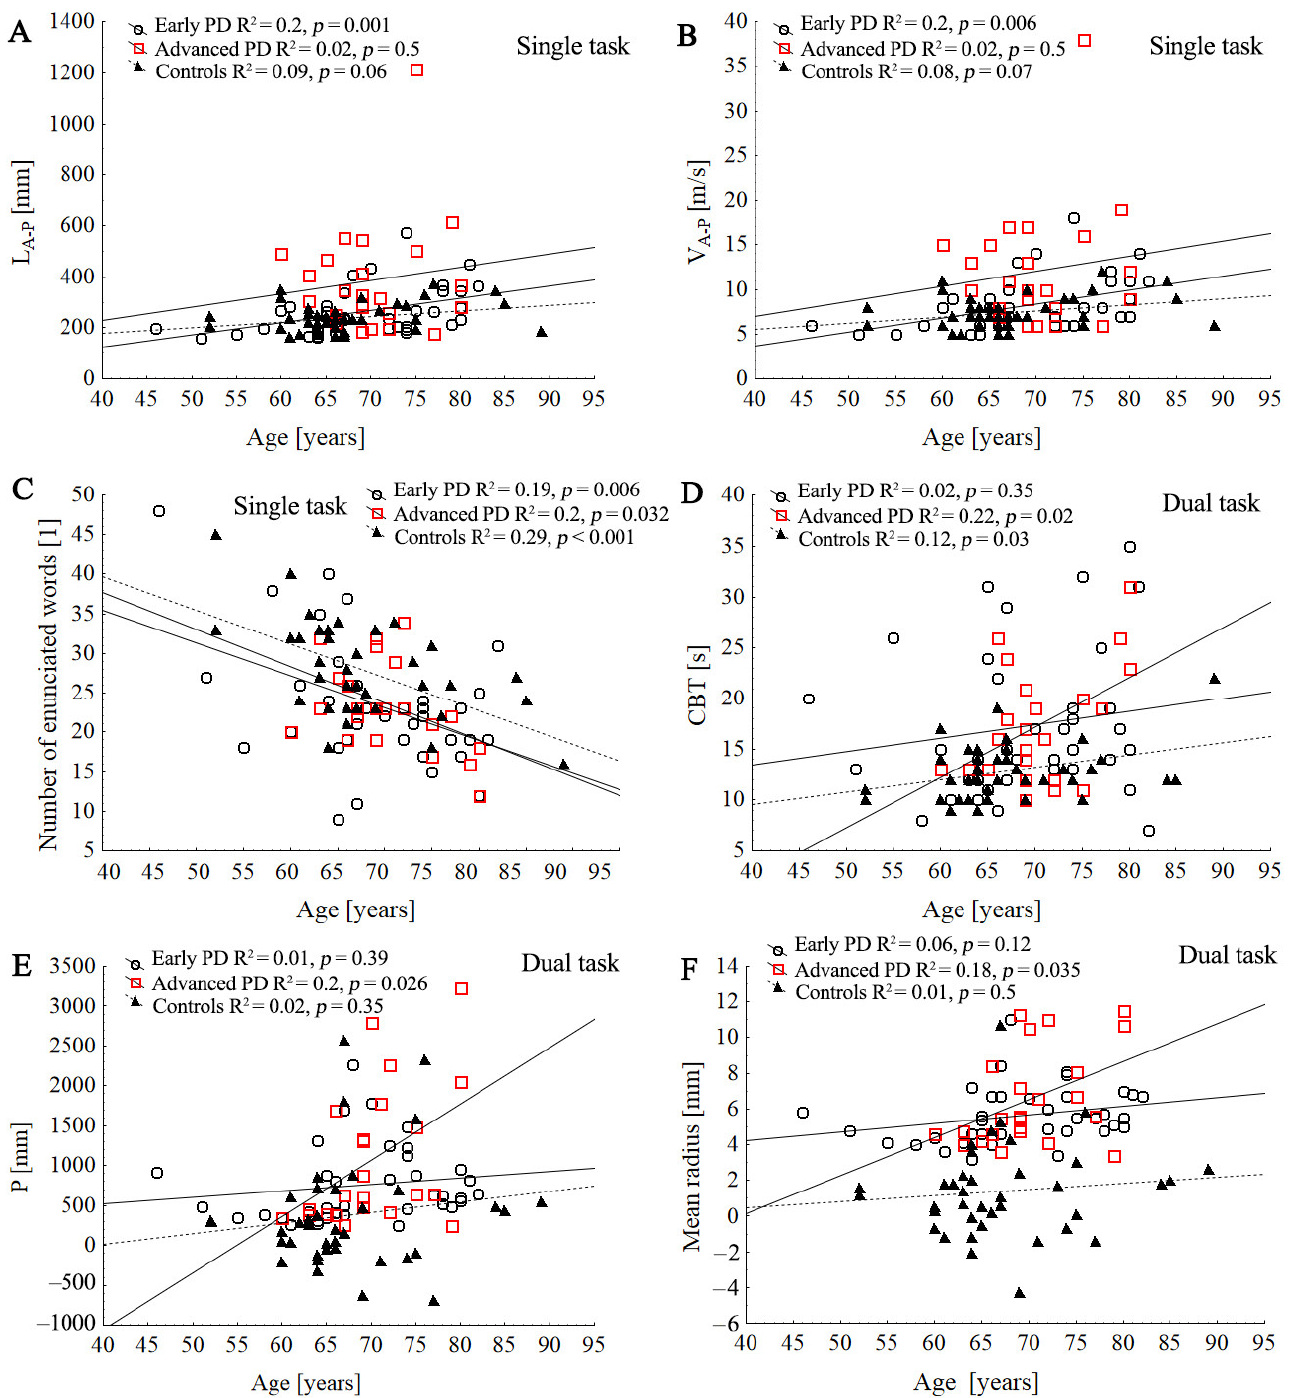
Figure 5. Comparison of three regression slopes by means of an ANCOVA. Scatter plot of the association between the age with stabilographic parameters and cognitive function tests in control and PD groups during single and dual task: L A-P ( A ), V A-P , ( B ), number of enunciated words ( C ), CBT ( D ), P ( E ), mean radius ( F ). Lines represent the slope of the linear regression between the subjects’ age and the dependent variable.